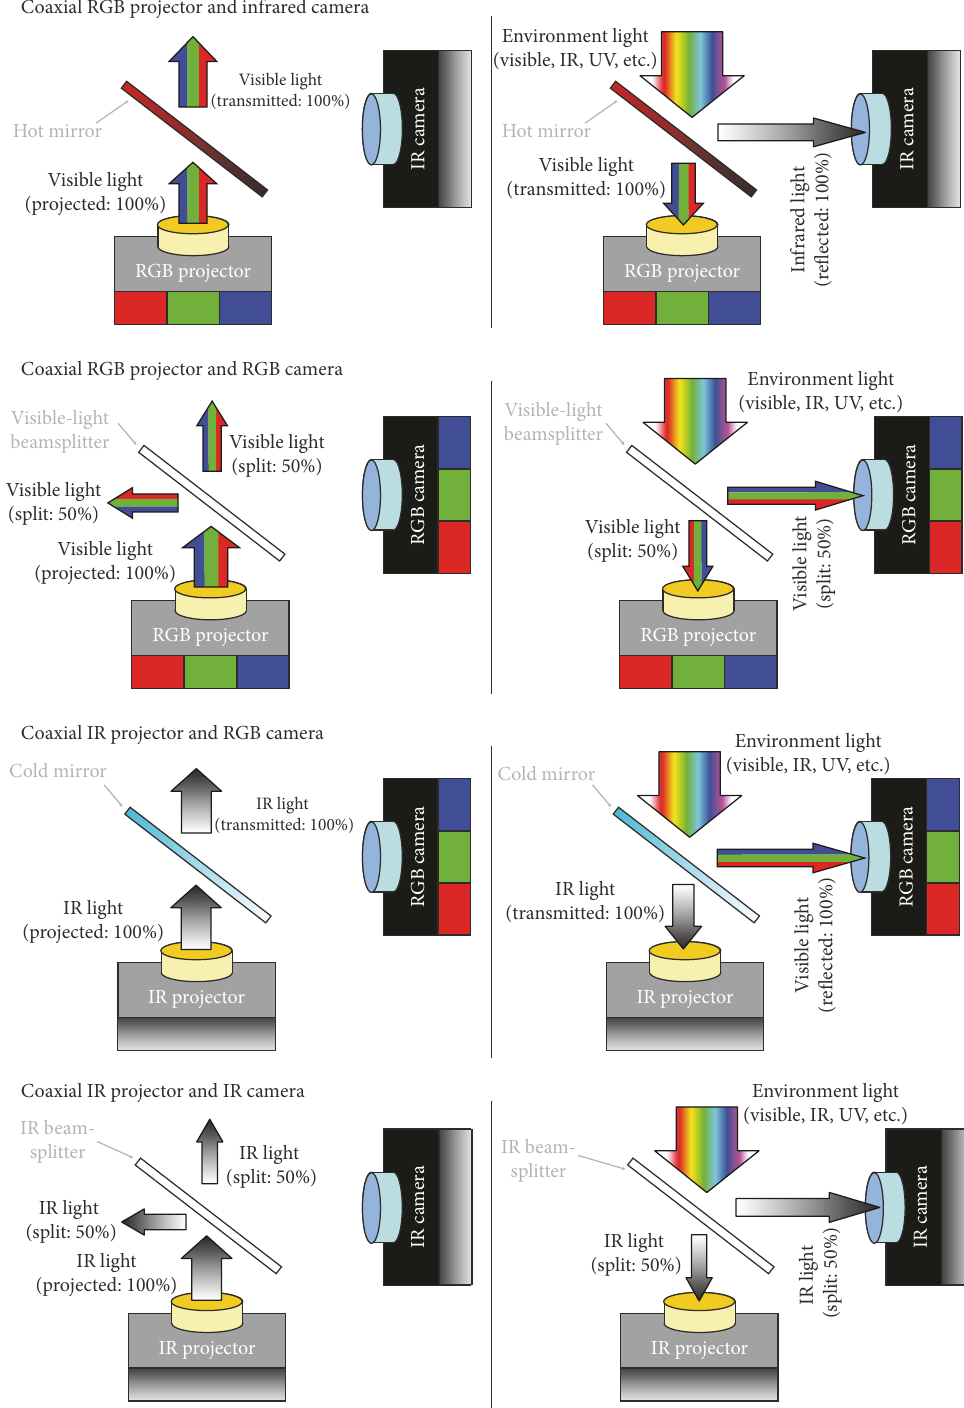
Figure 4: Four combinations of coaxializing a projector with a camera. The combination of RGB projector and infrared camera is used in [21] where two infrared illuminators are attached separately outside projection engine. The combination of RGB projector and RGB camera is also presented in [19,